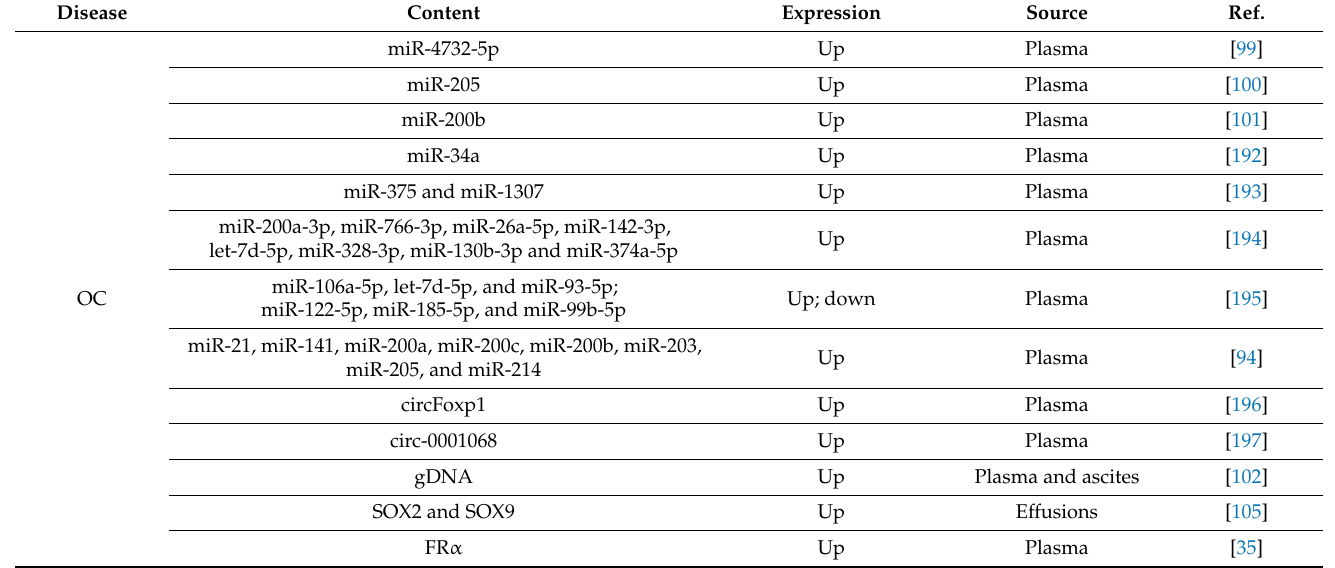
Table 2. sEV contents serving as diagnostic biomarkers in gynecologic diseases.